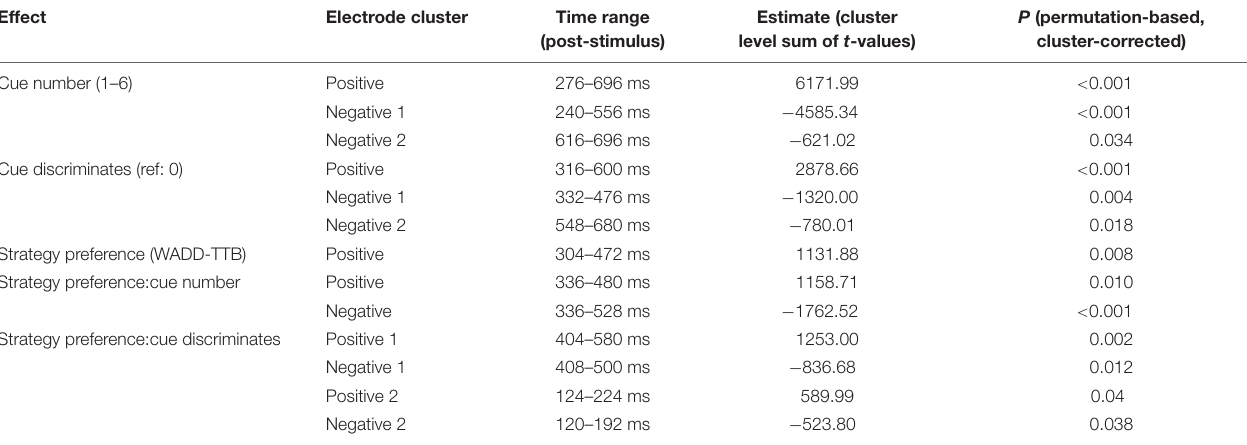
TABLE 1 | Model estimates for the effects of task characteristics and individual strategy preference on EEG